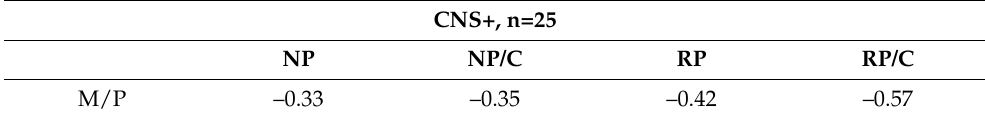
Table 6. Internal correlations between chromatographic parameters and control for CNS + APIs.